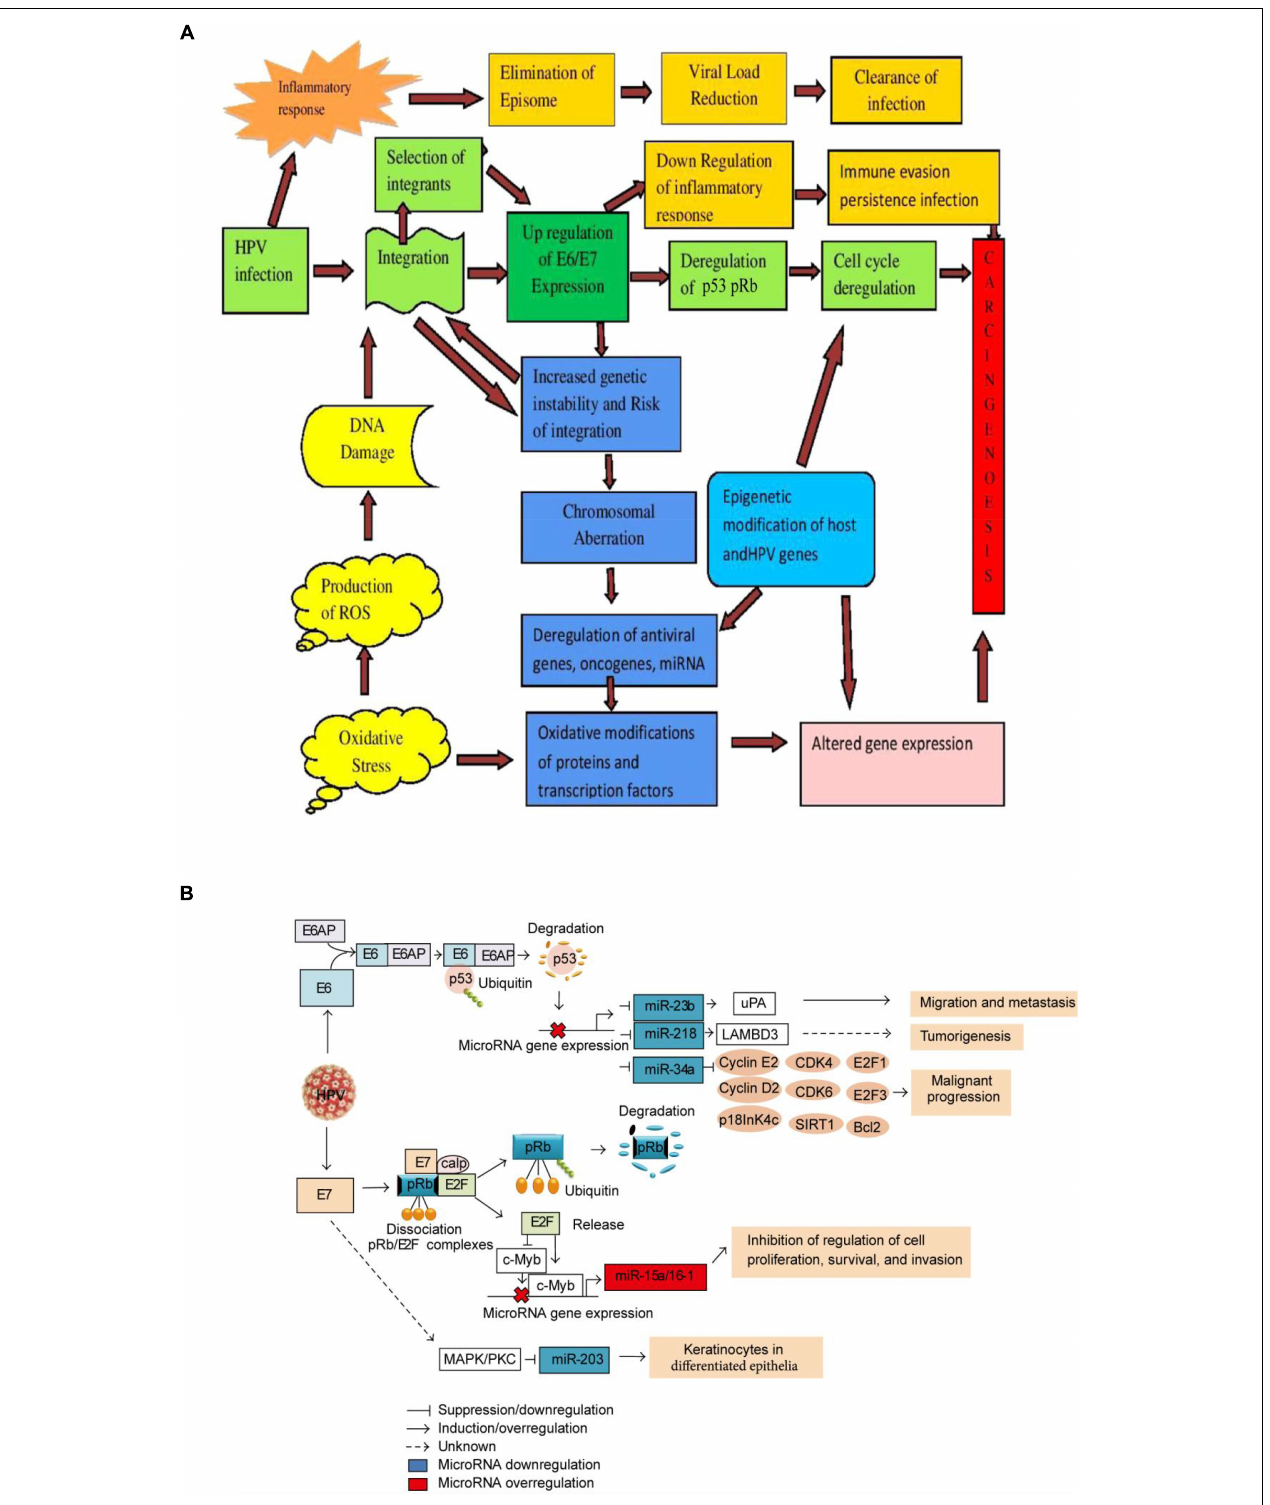
FIGURE 4 | Schematic model of HPV-driven carcinogenesis. (A) A multistep molecular mechanism of host-viral interaction (Senapati et al., 2016). The initial outcome of carcinogenesis is modulated by both viral (high-risk versus low-risk HPV types, HPV integration) and host factors (inflammatory response, oxidative stress). Inflammatory response upon initial infection such as IFN response plays role in reducing episomal HPV resulting clearance of infection. Integration of HPV is